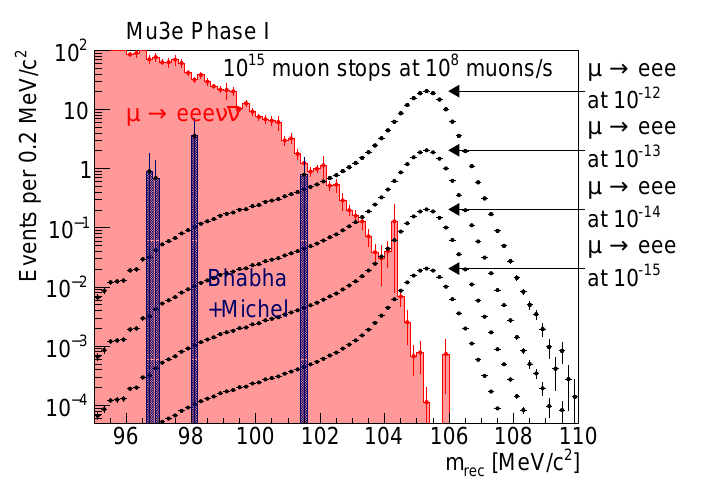
Figure 6: Expected invariant mass distribution of reconstructed µ → eee candidates. Back- ground from the µ → eee νν decays is shown in red and the dominant contribution to the accidental background in blue. The signal distribution (black points) is shown for di ff erent signal